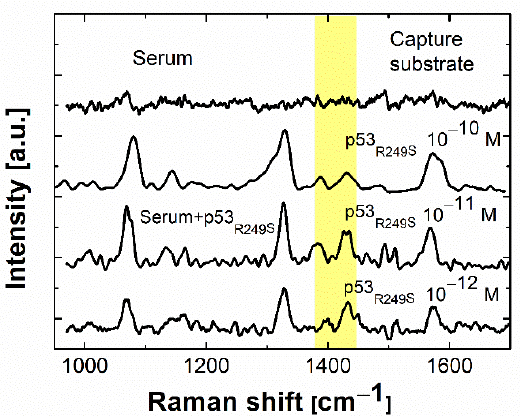
Figure 7. Raman spectra of the capture substrate functionalized with human serum and human se- rum/p53 R249S mixtures at different concentrations of p53 R249S and incubated with the 4-ATP-NP-Az probe. The yellow band highlights the Raman marker peaked at 1328 cm −1 .